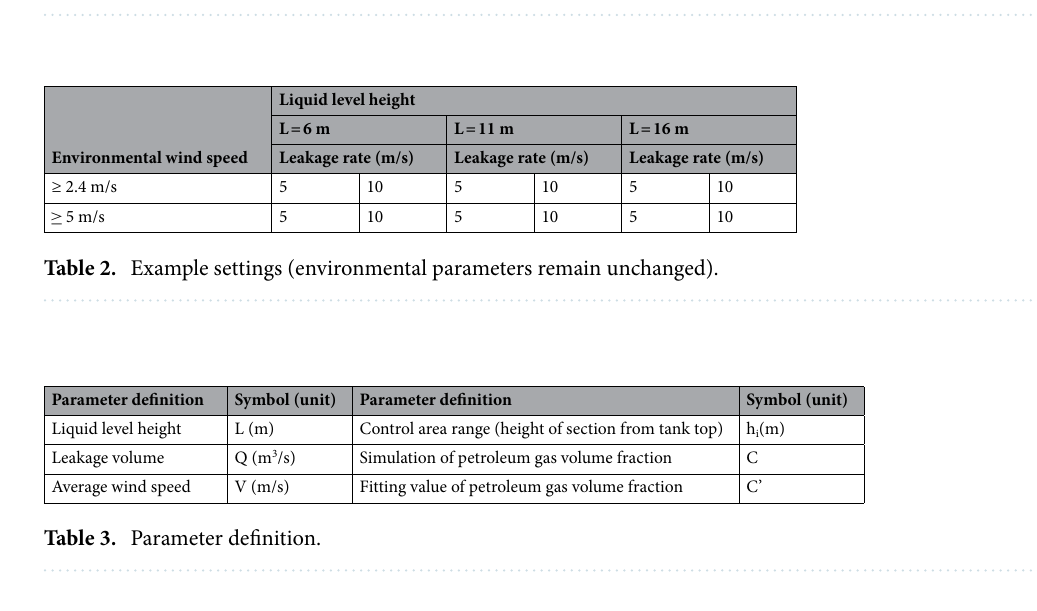
Figure 3. Grid independence verification.